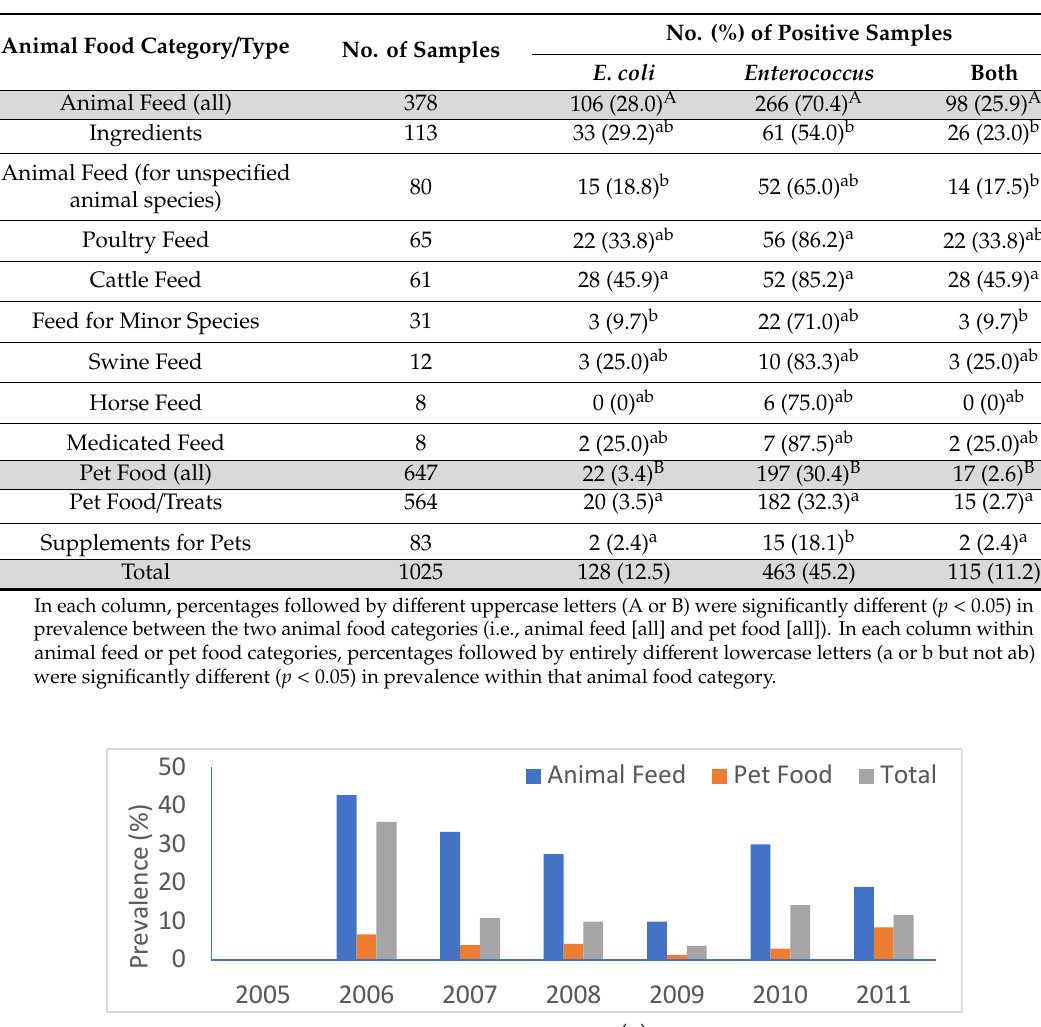
Table 1. Prevalence of E. coli and Enterococcus spp. in 1025 animal food samples.